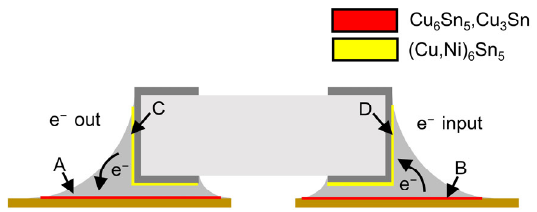
Figure 7. Diagram of the influence of current.